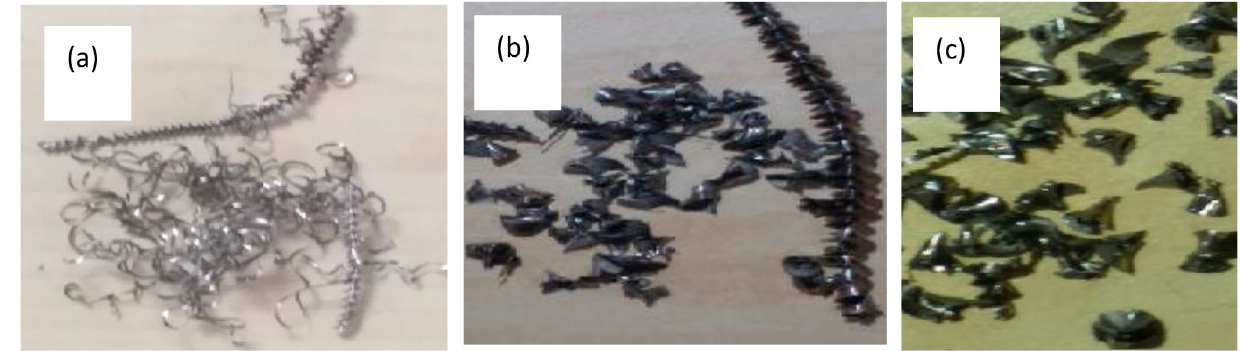
Fig. 9. (a-c) Chips generated at (a) N= 1500rpm, f =0.05 mm/rev, P =750* 10 3 Pa, Np (%) =1.5 (g), (b) N=1250 rpm, f= 0.125mm/rev, P =750* 10 3 Pa, Np =0.5% (g), (c) N=1500 rpm, f=0.125mm/rev, P = 500* 10 3 (Pa),